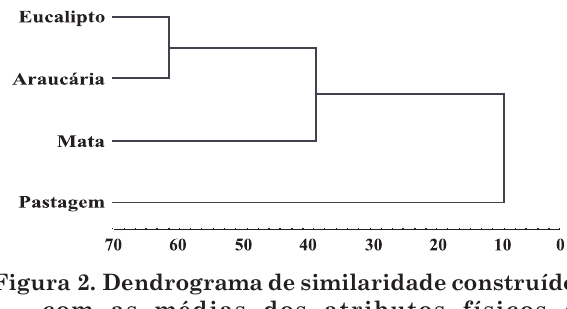
Figura 2. Dendrograma de similaridade construído com as médias dos atributos físicos e microbianos e os valores dos atributos químicos do solo e visuais dos diferentes ecossistemas estudados